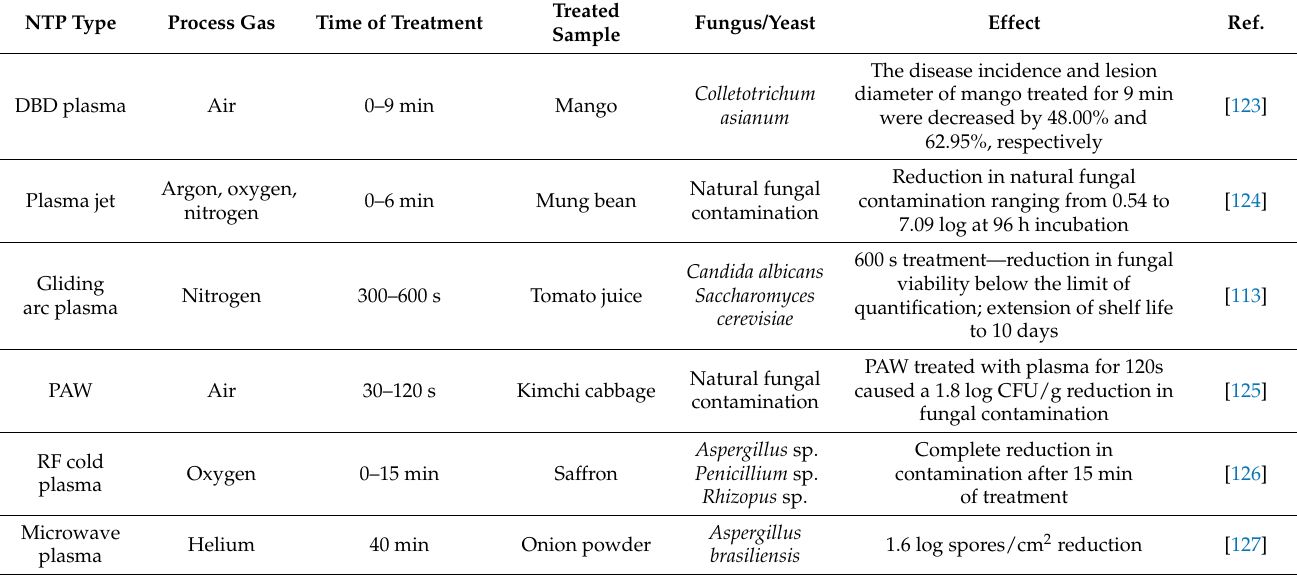
Table 2. The application of plasma in food and